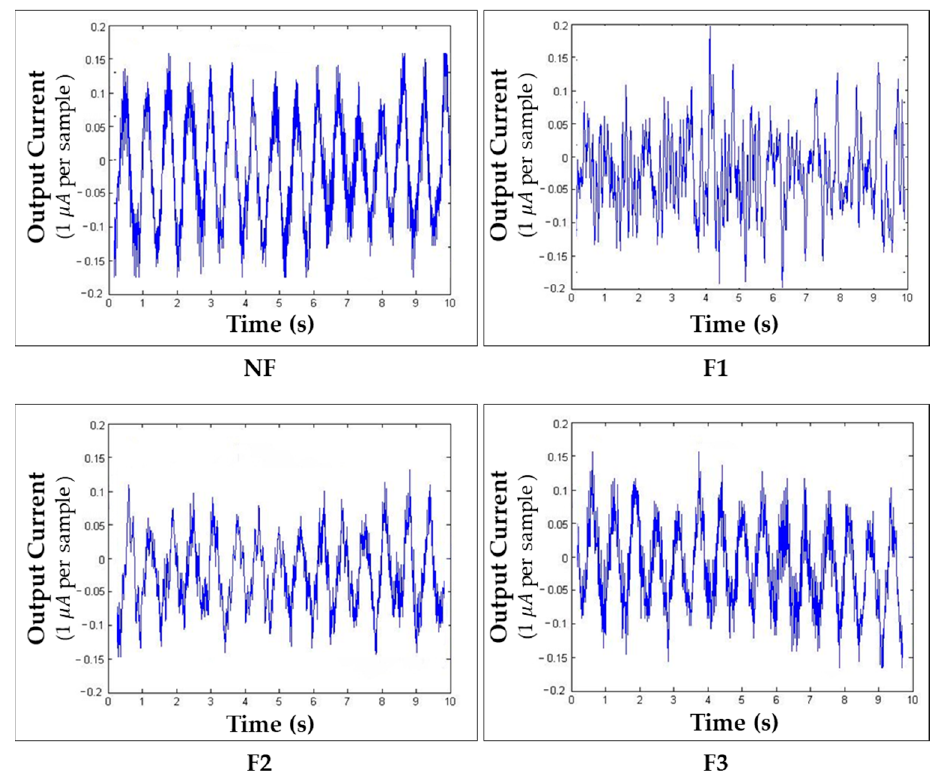
Figure 13. Output current corresponding to time according to the foaming conditions of IPMC: 1.6 Hz, 1 V.